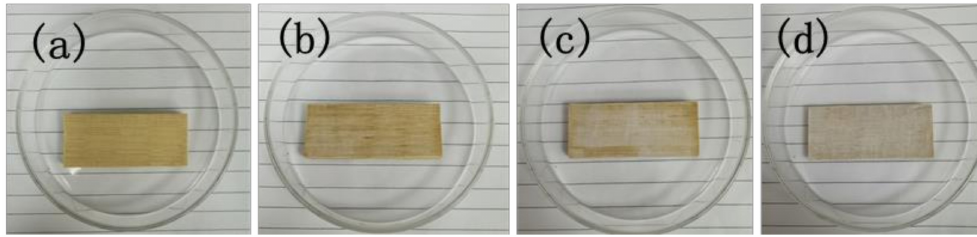
Figure 2. The appearance of the bamboo before and after treated: ( a ) original bamboo (OB), ( b ) U2-t1, ( c ) U2-t2, ( d )